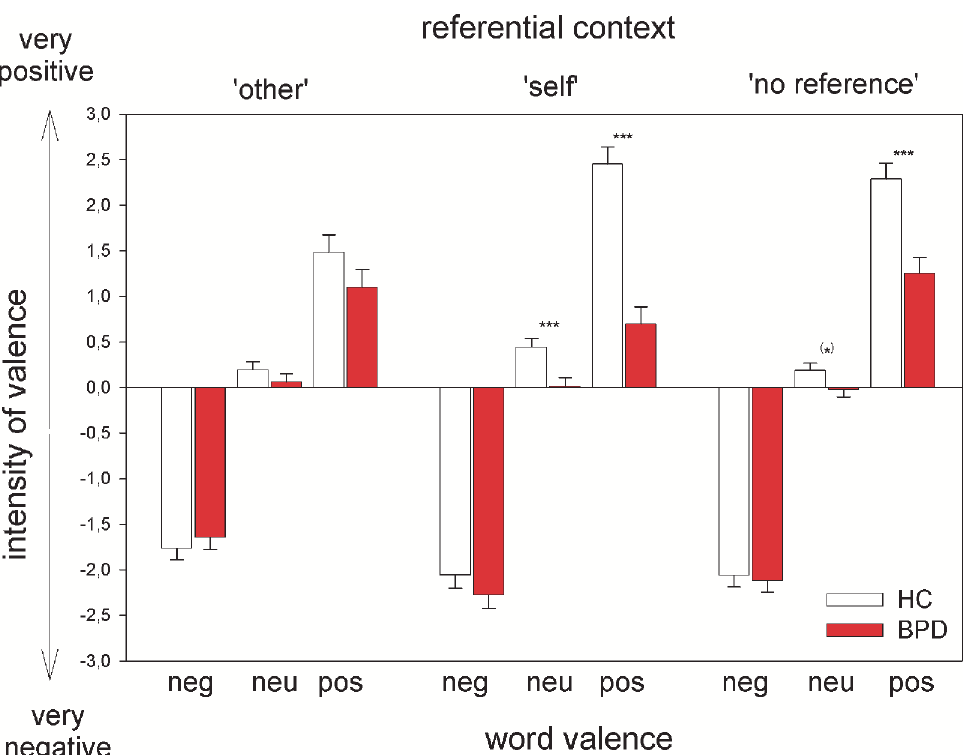
Figure 1. Word appraisal depending on referential context and word valence. Valence ratings of nouns depending on valence and referential context for healthy controls (HC) and patients with Borderline Personality Disorder (BPD). ( * ) p < .10, p ** < .01, *** p < .001.